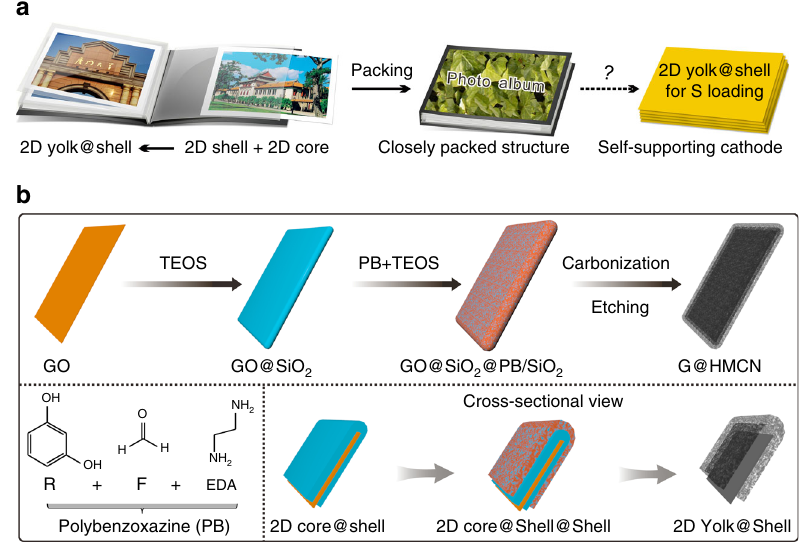
Fig. 1 Schematic illustration for the synthesis of G@HMCN. a Photo album inspired 2D yolk-shell nanostructure for the self-supporting carbon/sulfur cathode. b Two-step coating of GO with SiO 2 and porous carbon precursor PB/SiO 2 , followed by the carbonization and etching of SiO 2 to produce G@HMCN. Tetraethylorthosilicate (TEOS) was employed as the SiO 2 precursor, and resorcinol (R), formaldehyde (F), and ethylenediamine (EDA), were employed as the PB